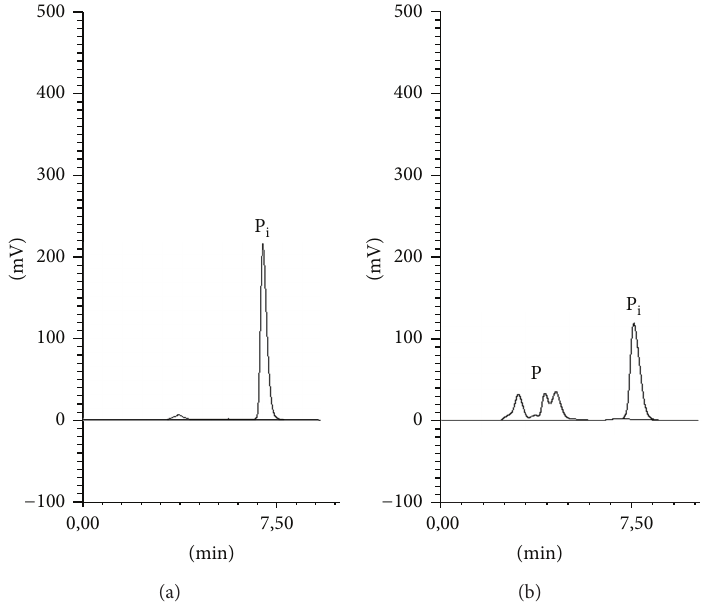
Figure1:HPLCchromatogramofceftiofursodiumafterincubation(a)0hand(b)23daysin0.2mg/mLglucosein22 ∘ C(P i :ceftiofursodium, P: degradation products).